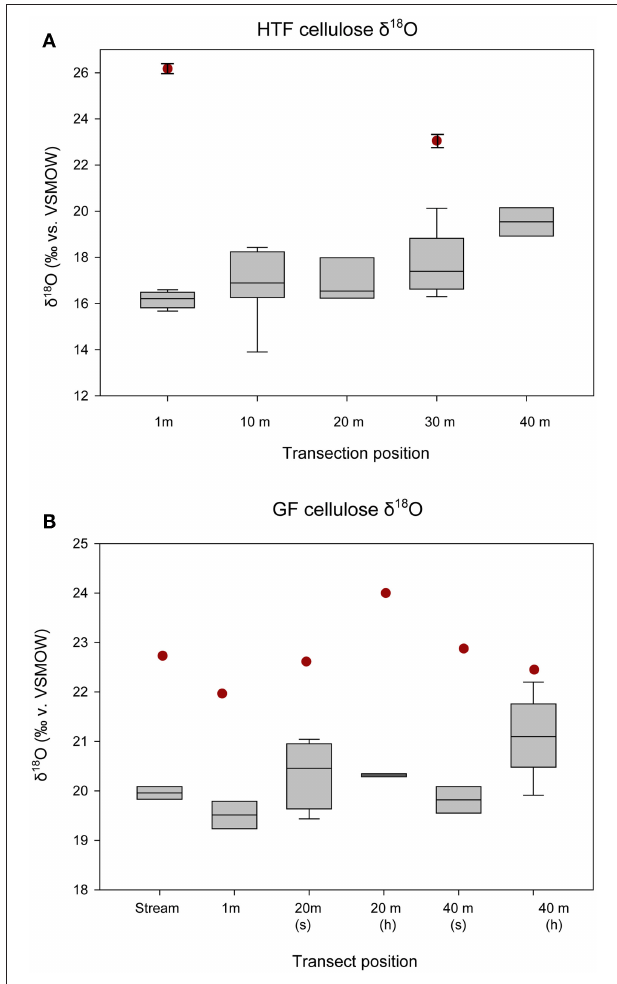
FIGURE 4 | δ 18 O cellulose values of bryophytes and Carex spp. by location on transect, starting from the stream and increasing out toward the forest edge. “S” refers to submerged, “h” refers to hummock for (A) HTF and (B) GF. The boxes and whiskers apply to the all measured bryophytes at each transect location. The red circles indicate Carex spp. leaf values at each transect location. At HTF, Carex spp. was only measured at two positions on the transect (1m, n = 4; 30m, n = 3), and only one Carex spp. replicate was analyzed at each position on the transect at GF and analytical errors are not shown.